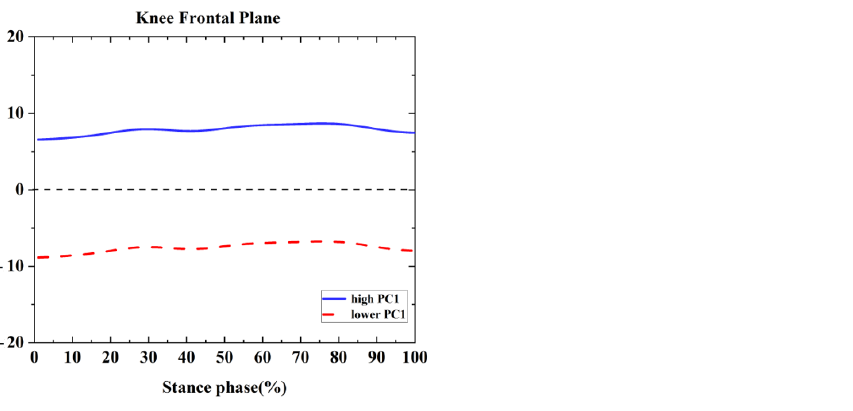
Figure 6. Principal components are retained for the knee. The waveform differences between competitive runners and recreational runners of reconstruction principal using the high and lower PC1-scores in the frontal plane.